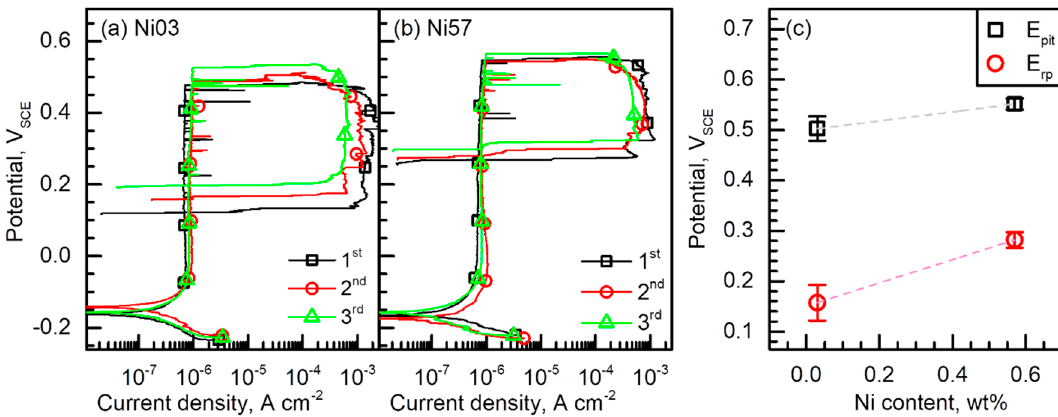
Figure 5. Repeatedly measured cyclic potentiodynamic polarization curves of ( a ) Ni03 and ( b ) Ni57 alloys. The polarization tests were obtained in 2 M NaCl at 40 °C with a potential sweep rate of 0.17 mV s − 1 . ( c ) Average pitting potential (E pit ) and repassivation potential (E rp ) of the alloys.